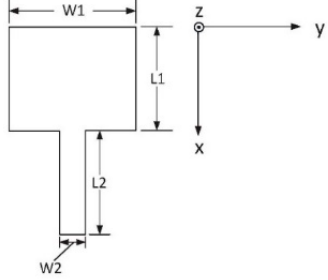
Figure 4. Schematic diagram of a microstrip patch antenna.